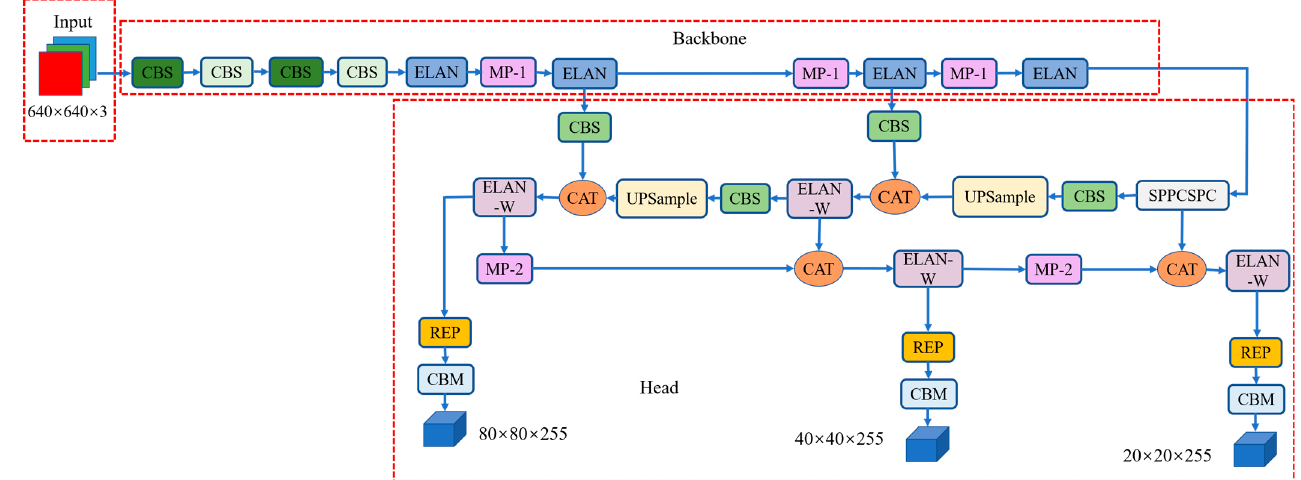
Figure 4. The network architecture of YOLOv7 (“CAT” indicates concatenation operation).